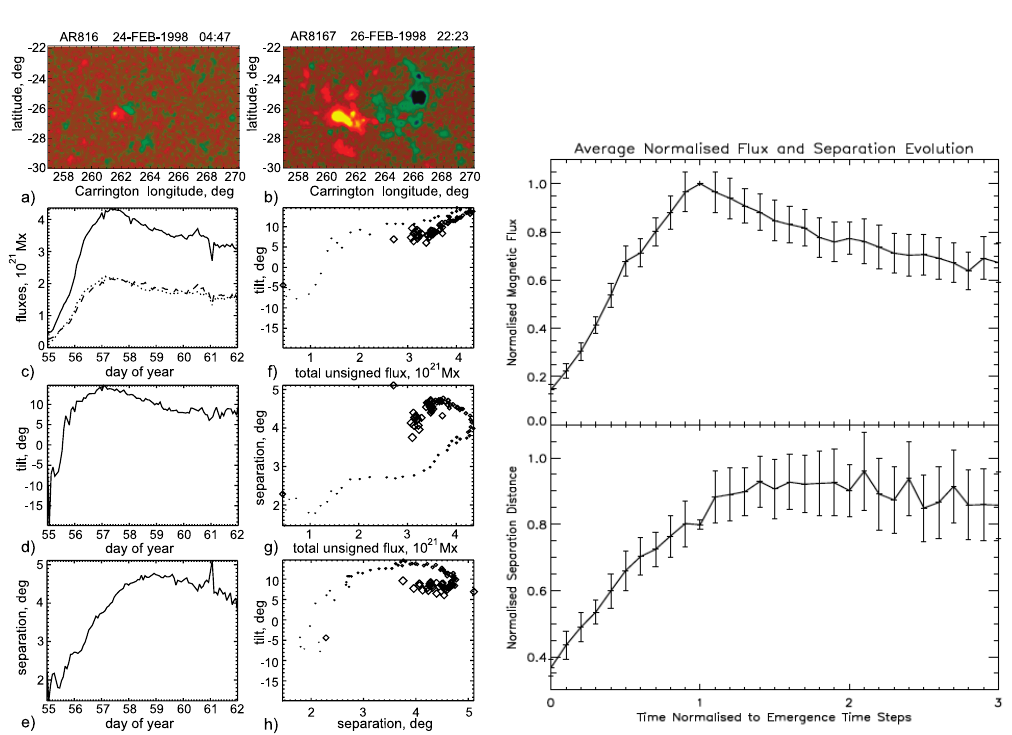
Figure 6: Left: Top panels show SOHO/MDI magnetograms taken at two stages of evolution of AR 8167 (a, b). The plots below show the evolution of magnetic flux, tilt angle, and separation of the centre of gravity of the two polarities as a function of time (c, d, e) and these three parameters plotted against each other (f, g, h). Image reproduced with permission from Kosovichev and Stenflo (2008), copyright by AAS. Right: Evolution of the average unsigned magnetic flux (above) and average separation distance (below), normalised to the peak values of 57 bipolar active regions that emerged on-disc in the period of 1997 – 2010 and observed with SOHO/MDI. Each time step is the average time for flux emergence derived from the top plot. The mean timescale was about 60 hours. The error bars are the standard errors on each averaged data point. The plot shows that polarity separation peak lags the peak flux by about 12 hours on average, and a slight reversal of the separation is seen after that, confirming the case study by Kosovichev and Stenflo (2008) in the left panel. Image reproduced with permission from Wallace Hartshorn (2012), copyright by